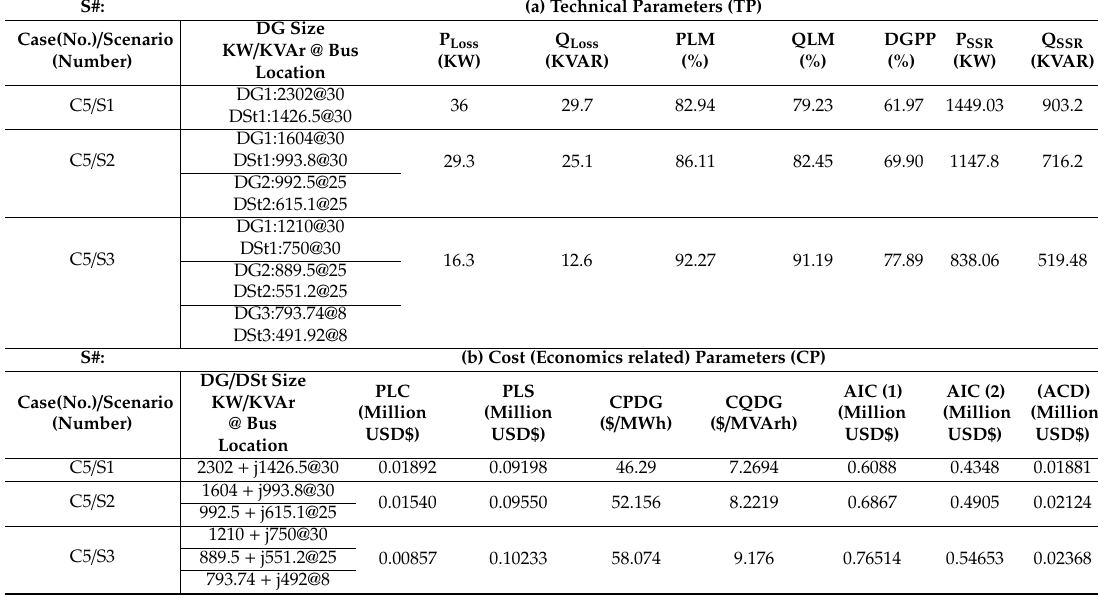
Table 9. (a) Overview of technical performance evaluation analysis in case 5 (33-bus). ( b) Overview of Cost-Economics performance evaluation analysis in case 5